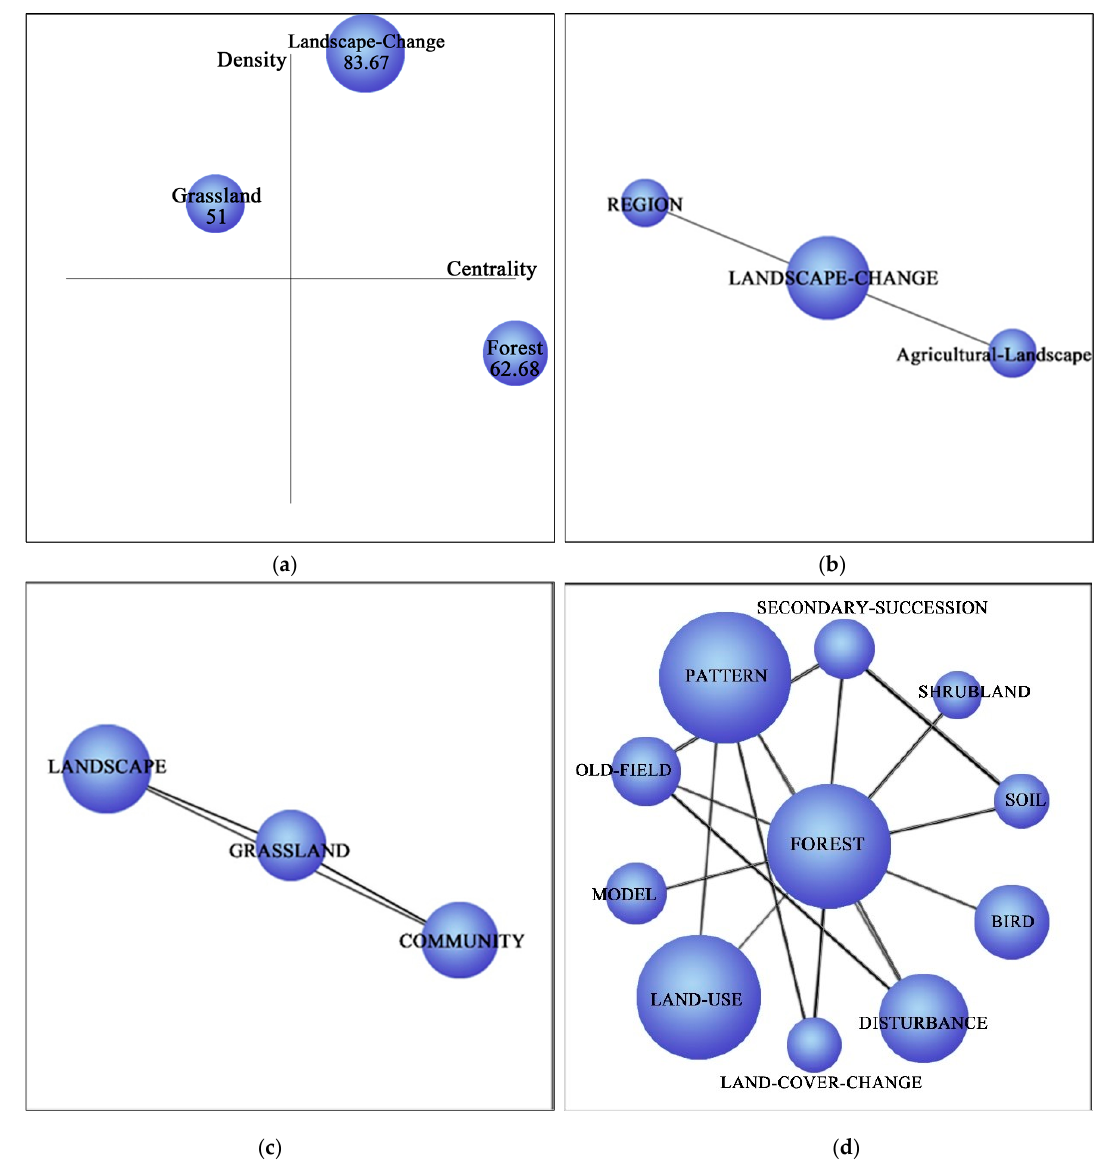
Figure 6. Farmland abandonment strategic diagram and-cluster network (1903–2004). ( a ) Strategic diagram for the 1903–2004 period; ( b ) landscape-change-cluster network map; ( c ) grassland-cluster network map; ( d ) forest-cluster network map.